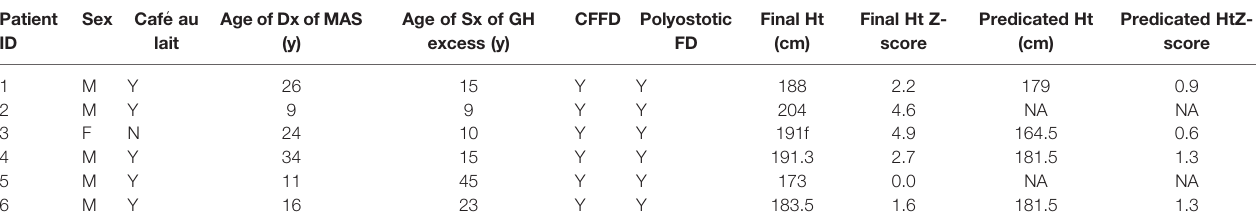
TABLE 4 | Clinical characteristics and fi nal height of patients diagnosed with GH excess without PP from PUMCH. Patient Sex Cafe ́ ID